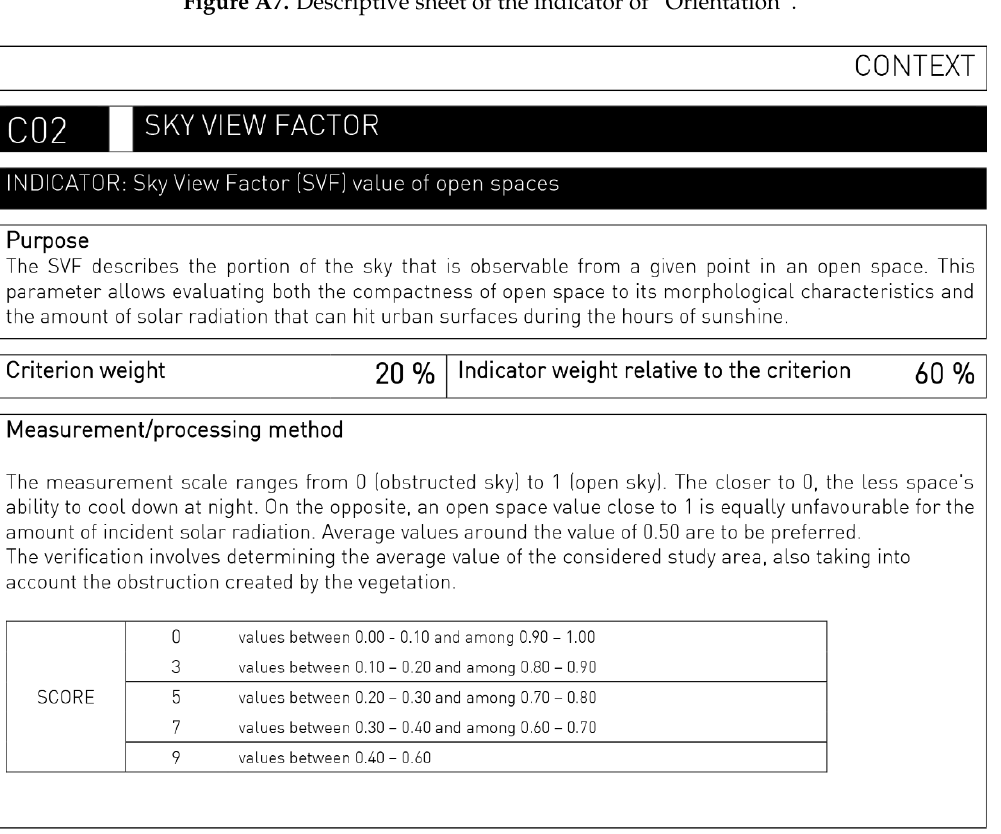
Figure A8. Descriptive sheet of the indicator of “Sky View Factor”.